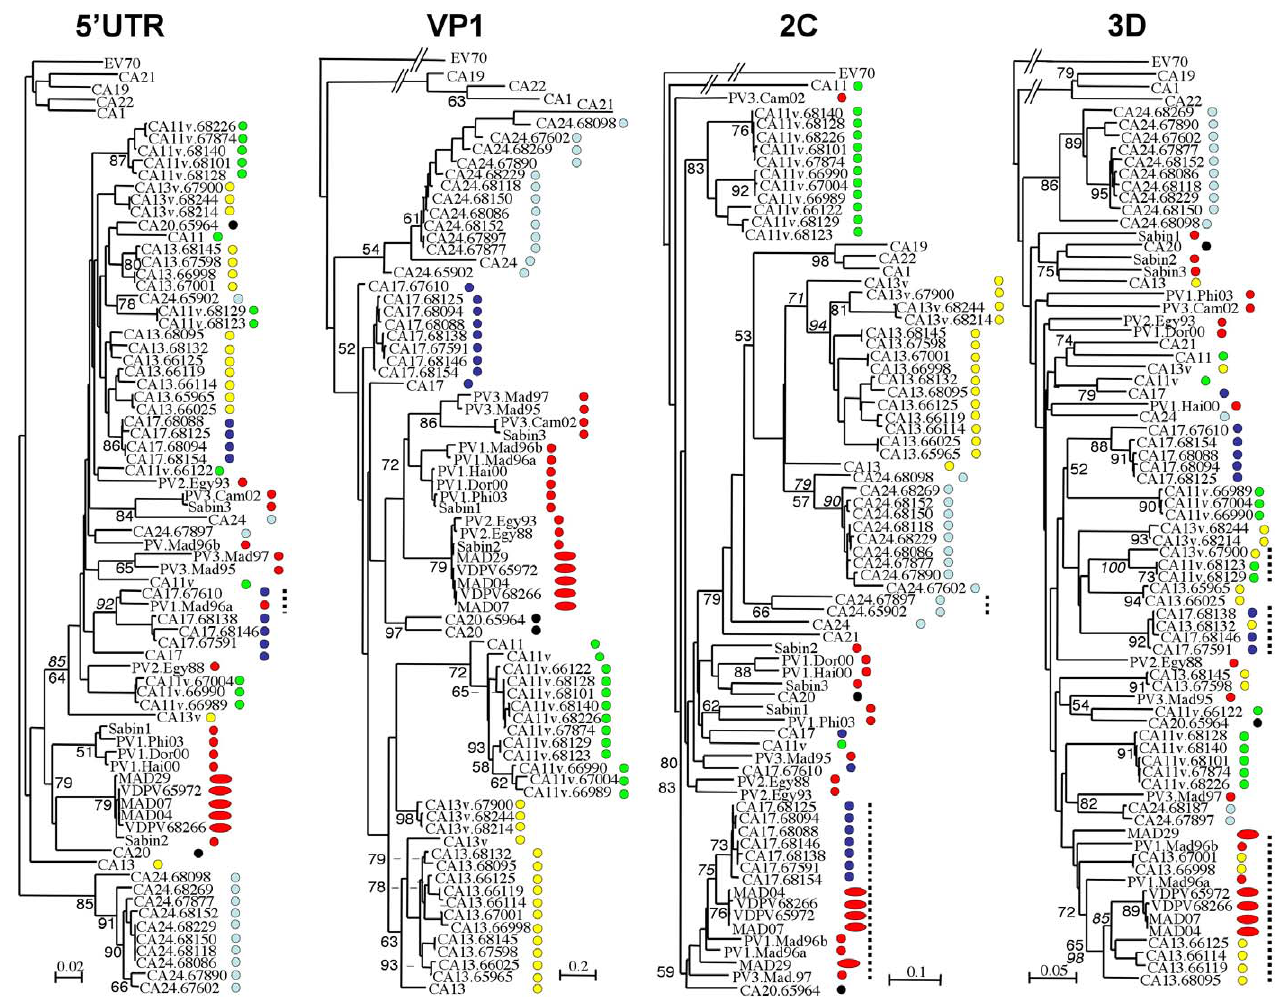
Figure 4. Phylogenetic Trees Depicting Genetic Relationships between Nucleotide Sequences of Enteroviruses of the HEV-C Species These neighbor-joining trees were based on nucleotide sequence alignments of part of the 5 9 UTR, the C-terminal third of the VP1-coding regions, part of the 2C-coding regions, and of the 3D pol regions. Branch lengths were calculated using PUZZLE and the Hasegawa, Kishino, and Yano (HKY) model of substitution [63]. The genetic distance is indicated (bar). Numbers at nodes correspond to the percentage of 25,000 puzzle steps supporting the distal cluster; numbers in italics representing the percentage of 1,000 bootstrap pseudoreplicates obtained with the DNADist/Neighbor and SEQBOOT programs of PHYLIP [65] are shown in several cases. Sequences of some of the last wild PV strains (PV3.Mad95, PV1.Mad96a, PV1.Mad96b, and PV3.Mad97) isolated in Madagascar (1995–1997) were used in addition to HEV-C prototype strains (CA1 to CA24). Selected PV strains isolated during the last poliomyelitis outbreak in Finland (PV3.Fin84) and during the recent VDPV outbreaks in Egypt (PV2.Egy93; PV2.Egy88), Haiti (PV1.Hai00), Dominican Republic (PV1.Dor00), and the Philippines (PV1.Phi01) are included. Sequences of the recombinant type 3 PV isolated from a poliomyelitis case in Cambodia in 2002 (PV3.Cam02) were also used. Nucleotide sequences of echovirus 70 (EV70) were used as outgroup. Identifiers of the HEV-C coxsackie A viruses isolated from healthy children in 2002 in Madagascar consist of the given serotype as assessed from partial sequencing [33] and the laboratory number. New VDPV isolates from healthy children are indicated with their laboratory numbers. Spots of different colors differentiate HEV-C serotypes and polioviruses (red). VDPVs from Madagascar are indicated by oblong spots. According to the Eight Report of the ICTV [56], former CA15 and CA18 are considered as antigenic variants of CA11 and CA13, and are now named CA11v and CA13v, respectively. All field isolates from Madagascar, except isolates CA24.65902 and CA24.68187, were sequenced in the four regions. Vertical dotted lines indicate groups of isolates of particular interest that are discussed in the text.